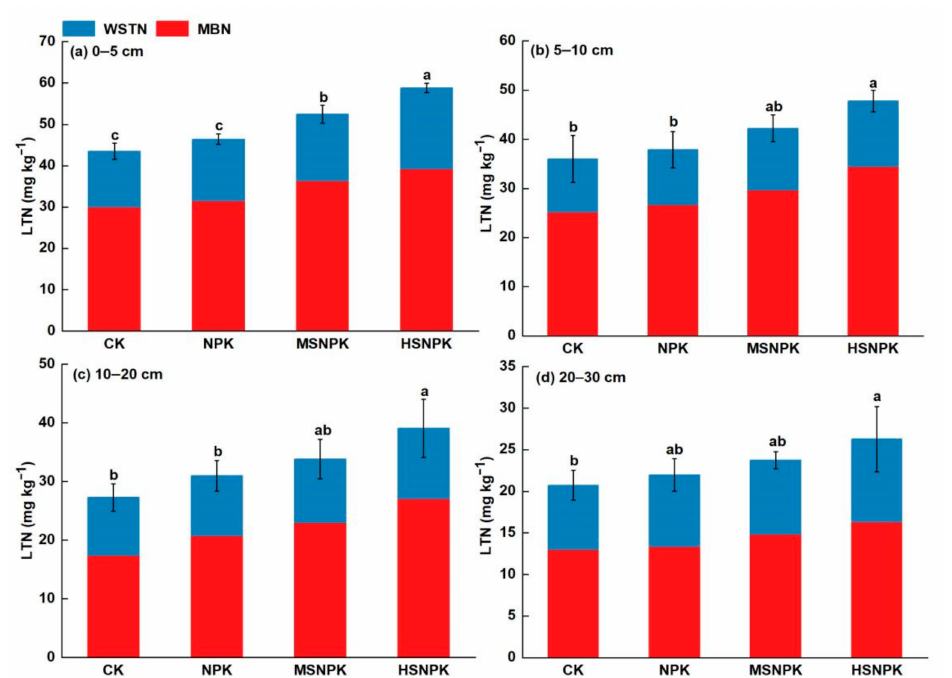
Figure 7. Changes in soil LTN content at different soil layers under different treatments. The values are means ± SD ( n = 3). Different letters mean statistically significant differences at the 0.05 level. CK: unfertilized control; NPK: mineral NPK fertilizer; MSNPK: moderate wheat straw incorporation (3 t ha − 1 ) plus NPK; HSNPK: high wheat straw incorporation (6 t ha − 1 ) plus NPK. LTN: total labile N; WSTN: total water-soluble N; MBN: microbial biomass